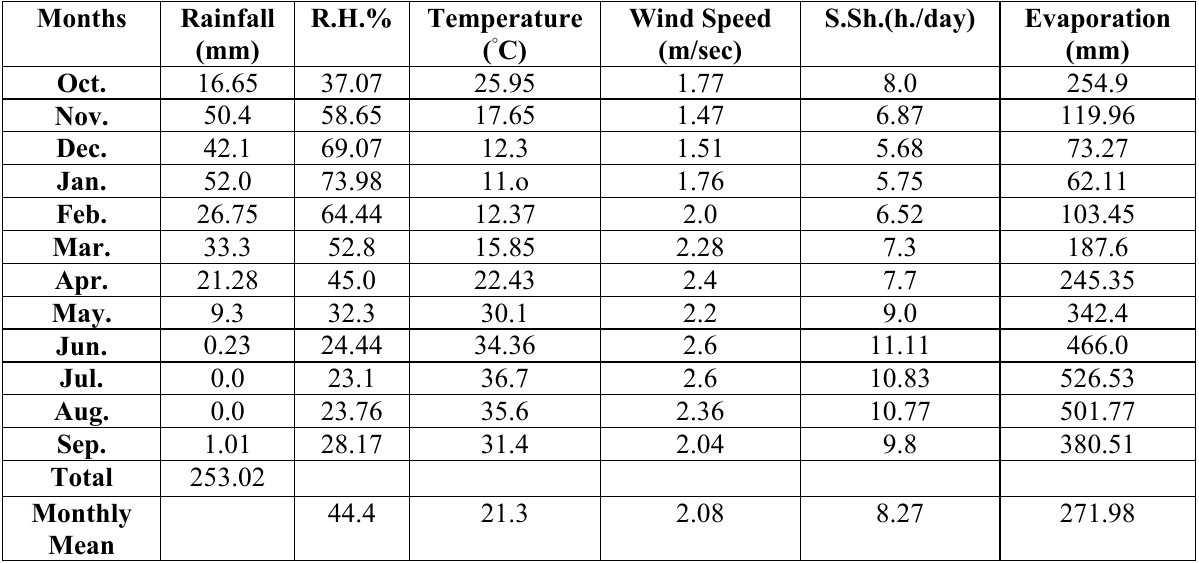
proposed station Mandali Table 2. Table 2: The monthly averages of rainfall, relative humidity, temperature, wind speed and sun shine and evaporation basin class (a) for the period (1990-2013), calculated for the station Mandali (Ma)